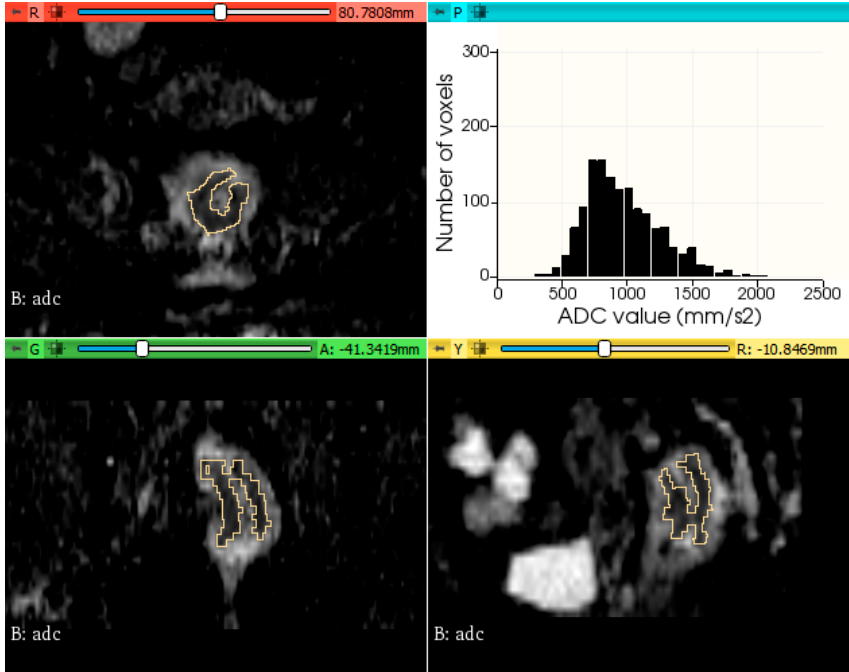
Figure 3. Example of rectal tumor VOI segmentation on ADC map and histogram plot of the ADC values from a patient with metachronous metastases.